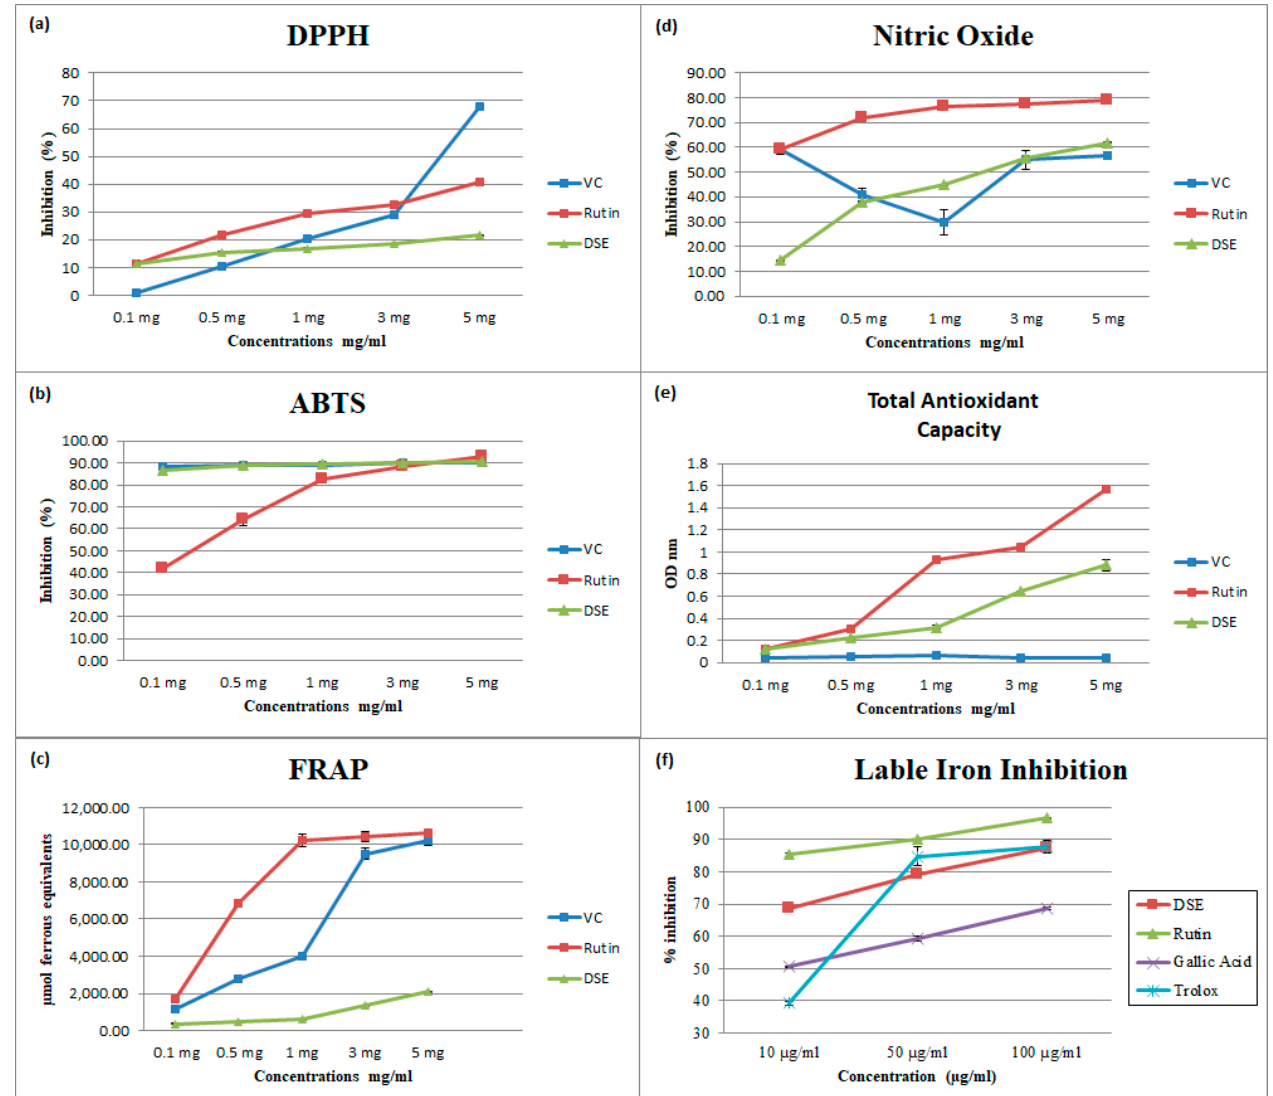
Figure 1. ( a ) 2,2-diphenyl-1-picrylhydrazyl , ( DPPH • ), ( b ) 2,2’-azino-bis(3-ethylbenzothiazoline-6- sulfonic acid, ( ABTS • ), ( c ) Ferric-Reducing/Antioxidant Power (FRAP), ( d ) Nitric Oxide, and ( e ) Total Antioxidant Capacity assays for date seed extract, (DSE), vitamin C, and rutin at different concentrations. ( f ) Effects of DSE, gallic acid, rutin, and Trolox on inhibition of iron release from ferritin by superoxide. Data are expressed as the mean ± SD; n = 3.